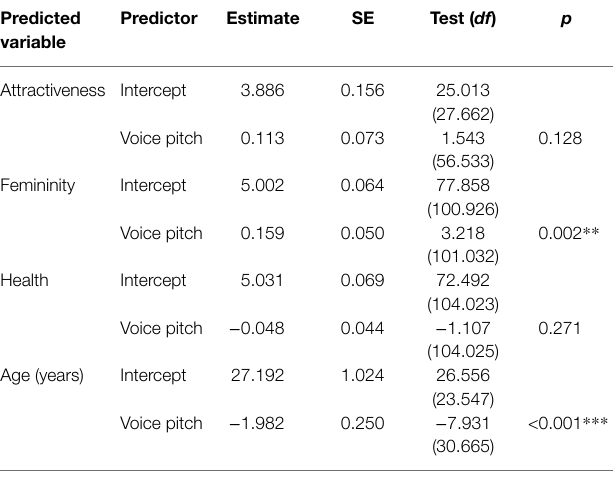
TABLE 5 | Linear mixed models with voice pitch condition (original vs. increased) as the fixed effect and ratings of attractiveness, femininity, health, and age of faces as the dependent